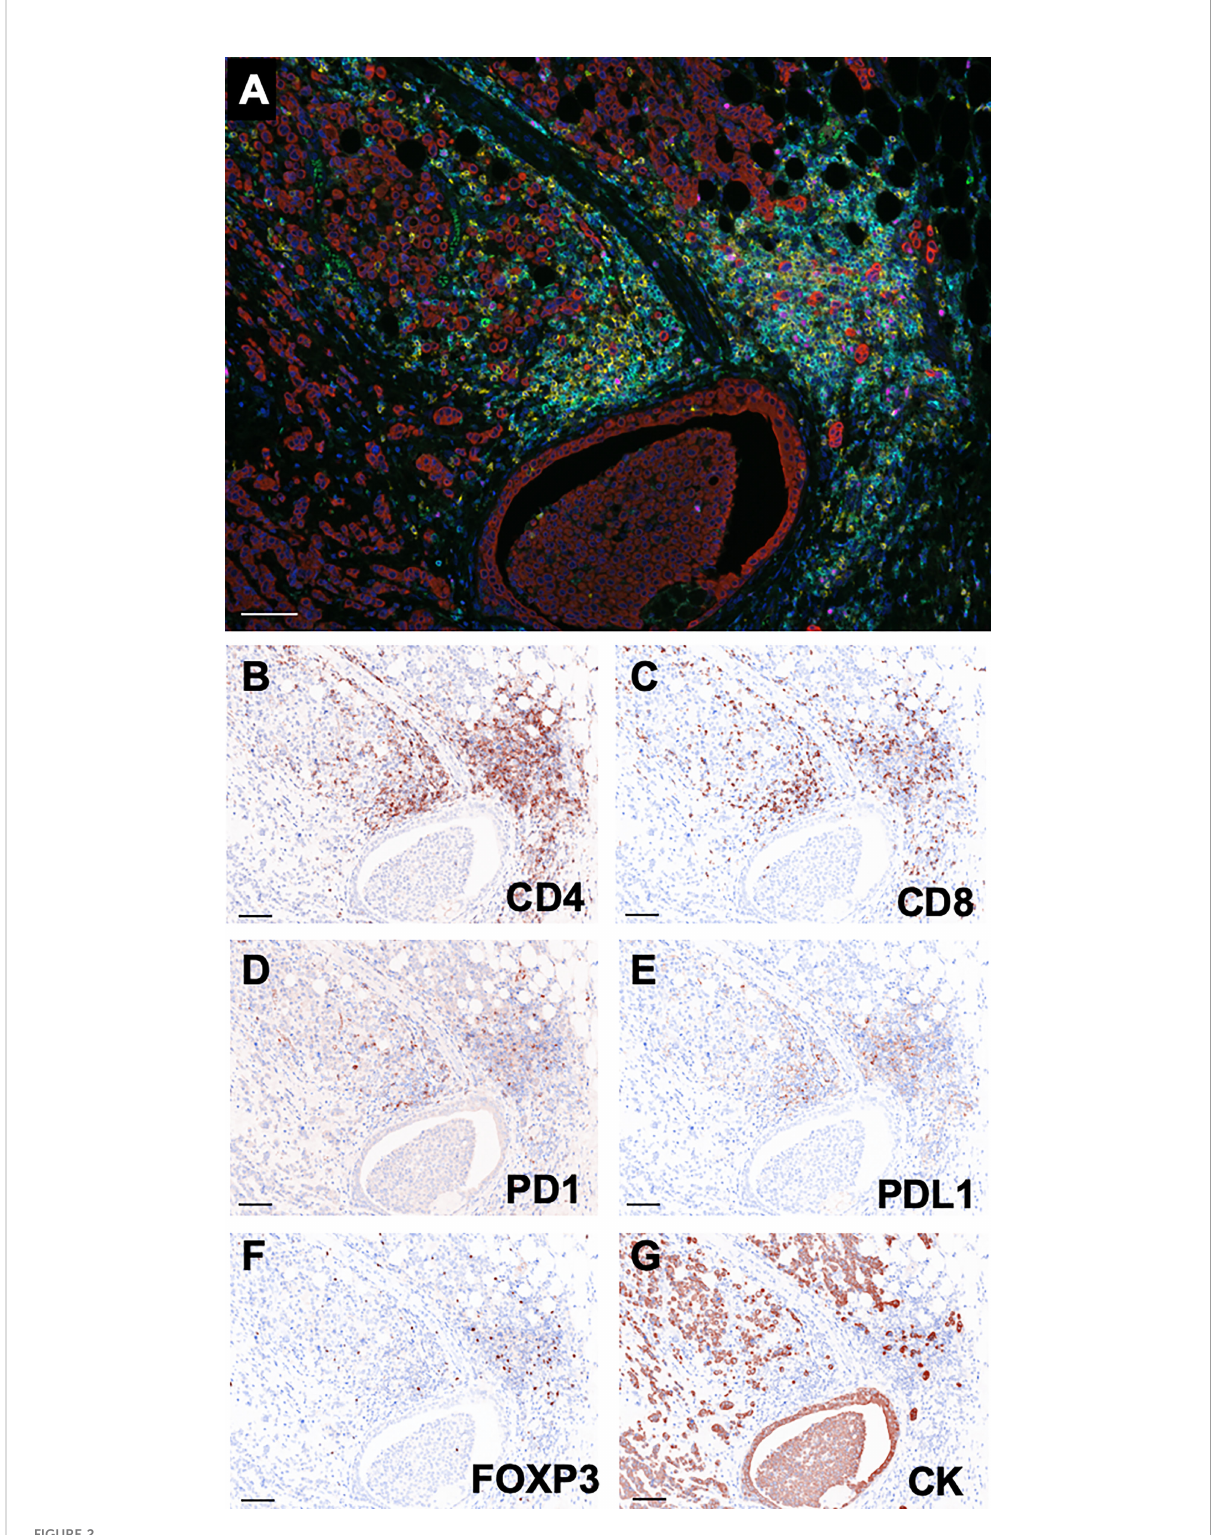
FIGURE 2 Representative multi-colored immunostaining and virtual pathological images. (A) Composite image (7-color image) of representative lesion. Virtual pathological image of (B) CD4, (C) CD8, (D) PD1, (E) PDL1, (F) FOXP3, (G) Pan-CK in a single tissue section. Brownish-colored areas indicate a positive signal. Scale bars indicate 100 m